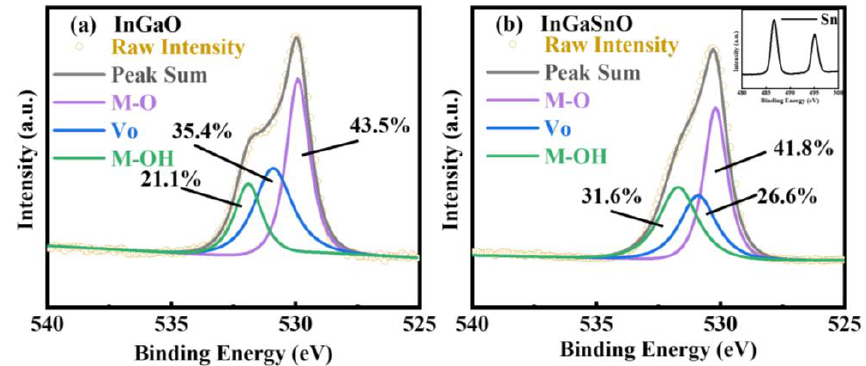
Figure 4. XPS O 1s spectra collected from ( a ) InGaO and ( b ) InGaSnO semiconductor layers. Inset: Sn 3d spectrum collected from InGaSnO semiconductor.